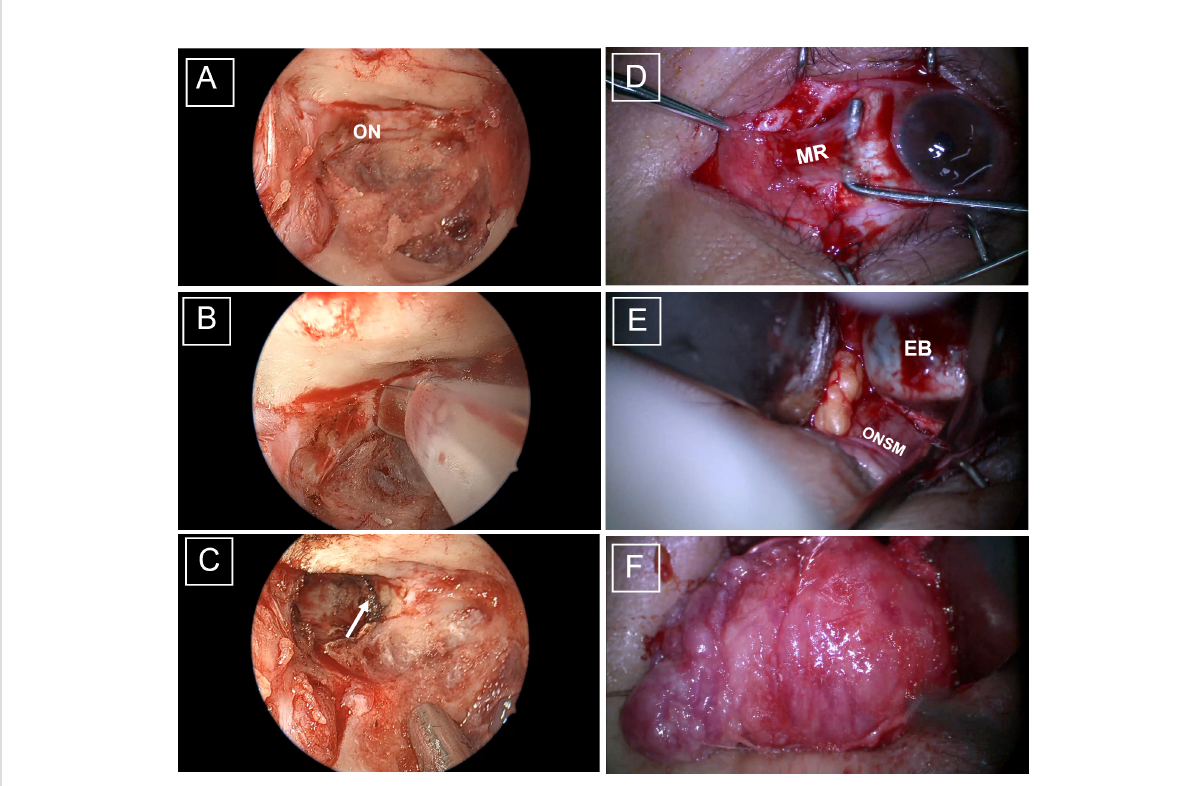
FIGURE 1 Intraoperative views of the combined endoscopic transethmoid and transconjunctival approach for optic nerve tumor resection. (A) Full exposure of the right optic canal. (B) The optic nerve was dissected using an electric knife, with the optic nerve section indicated by the white arrow (C) . (D) After incision of the conjunctiva, the muscle was detached from the bulb according to the position of the muscle. (E) The tumor was carefully dissected, with the optic nerve tightly clipped against the eyeball. (F) The tumor was gently peeled away from the periorbita. ON, optic nerve; MR, medial rectus muscle; EB, eyeball; ONSM, optic nerve sheath